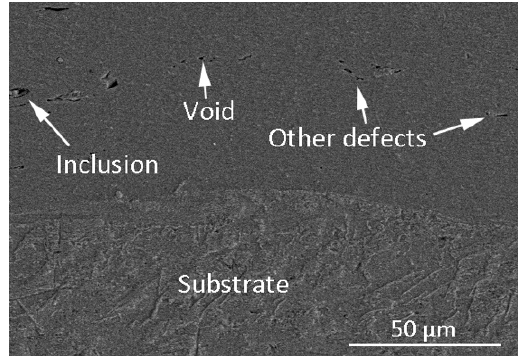
Figure 5. Magnification of marked region “A” in Figure 2b.